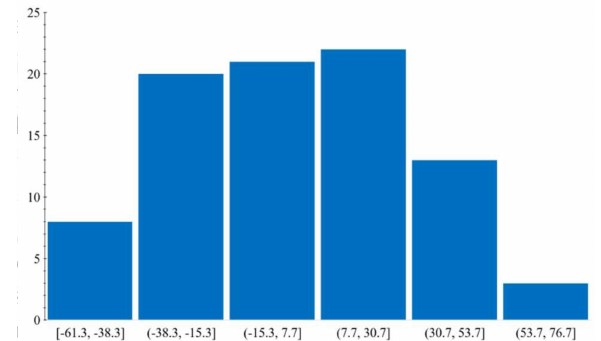
Figure 1. Distribution of zeta potential values.